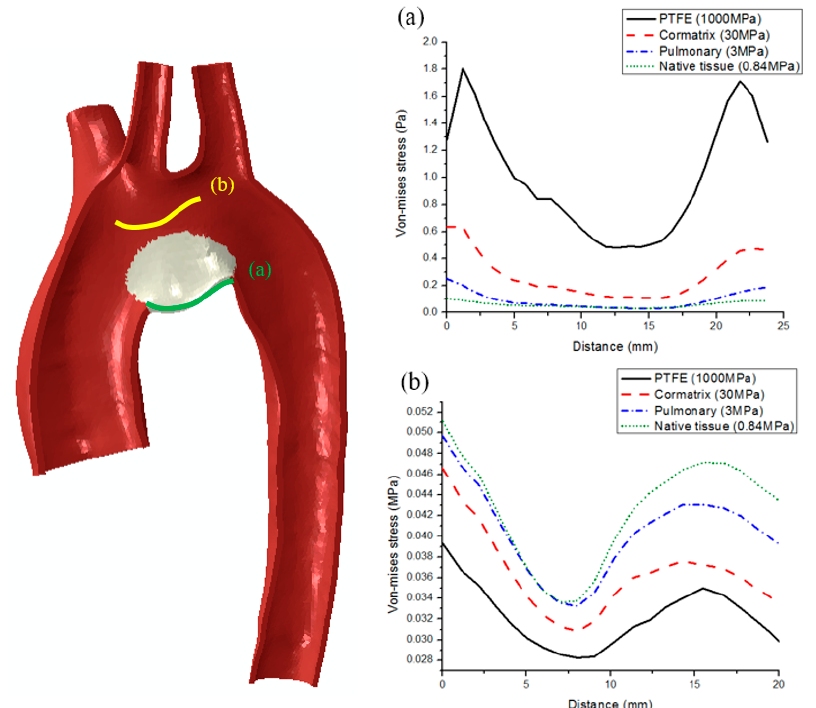
Figure 9. Stress distributions at t = 0.4 s (peak systolic pressure): ( a ) PTFE graft = 1000 MPa, ( b ) Cormatrix graft = 30 MPa, ( c ) pulmonary graft = 3 MPa, and ( d ) native tissue equivalent graft = 0.84 MPa.